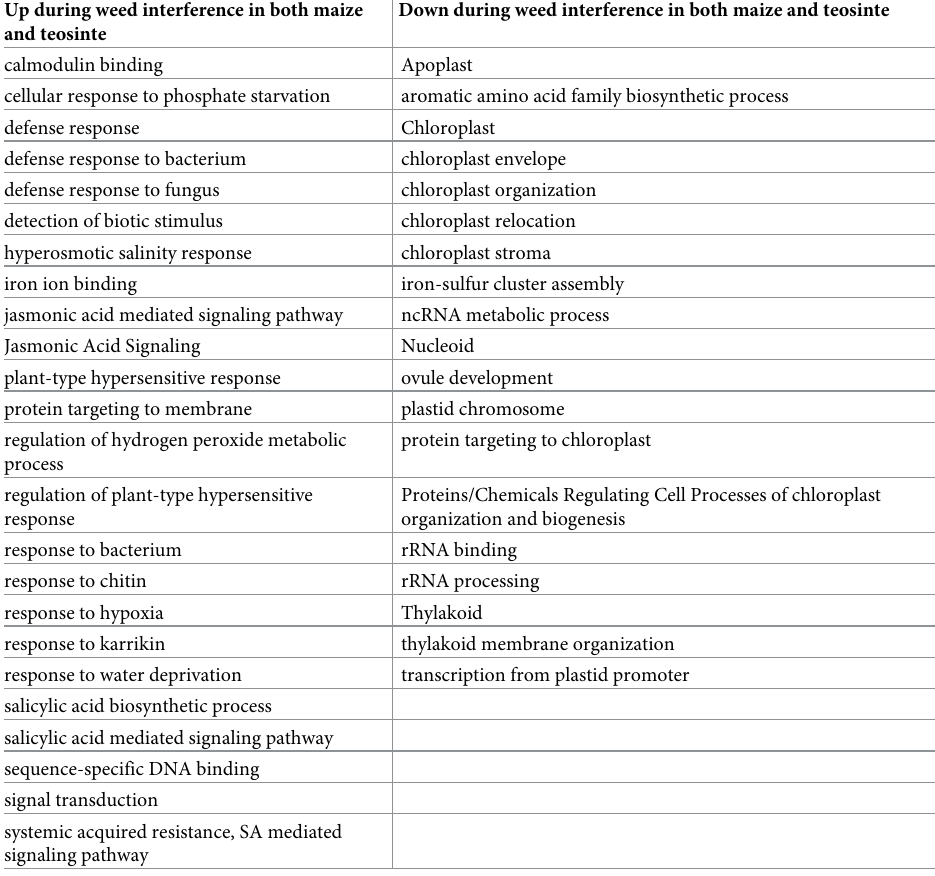
Table 8. Over-represented gene ontologies common between maize and teosinte.